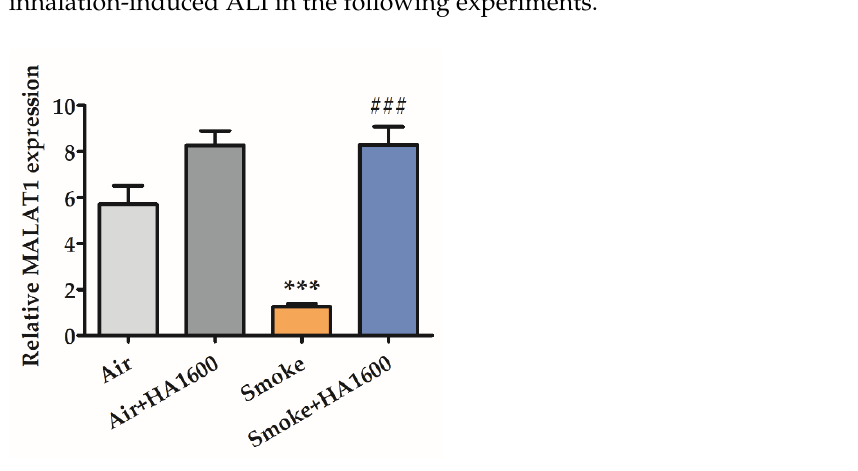
Figure 3. HA1600 increased metastasis-associated lung adenocarcinoma transcript 1 ( MALAT1 ) expression in smoke-induced ALI. Mice were allowed to recover after smoke exposure for 24 h, and the level of MALAT1 in lung tissues was analyzed by quantitative real-time (RT) PCR. Data are represented as means ± SEM ( n = 6). *** p < 0.001 vs. Air group (the control group); ### p < 0.001 vs. Smoke group.